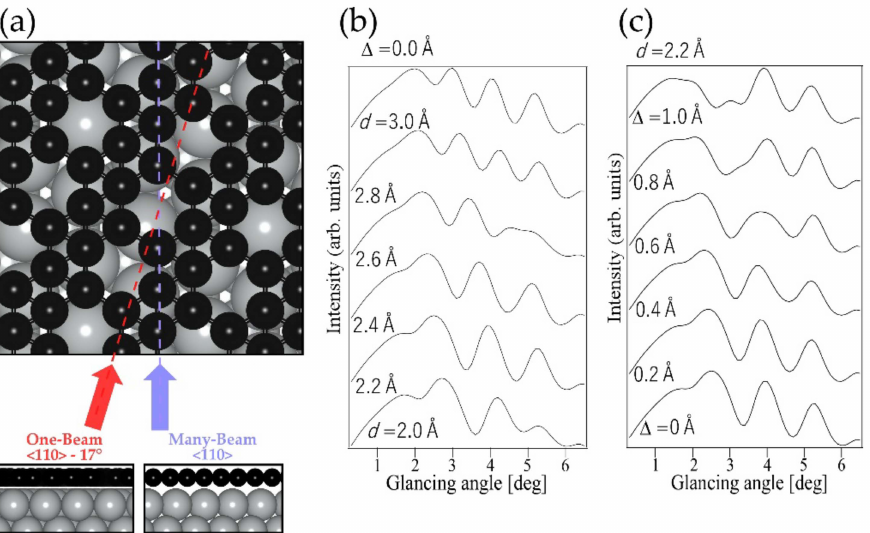
Figure 1. ( a ) Structural model of χ 3 -borophene. Beam directions of the one- and many-beam condition are depicted by the red and blue arrows, respectively. The bottom pictures show the side view along each condition. ( b ) Calculated rocking curves of χ 3 -borophene in one-beam condition with different interlayer distance d , with no buckling ( ∆ = 0.0 Å). ( c ) Calculated rocking curves of χ 3 -borophene with different buckling ∆ , with fixed interlayer distance ( d = 2.2 Å) which is the height of the lowest boron atoms from the Ag